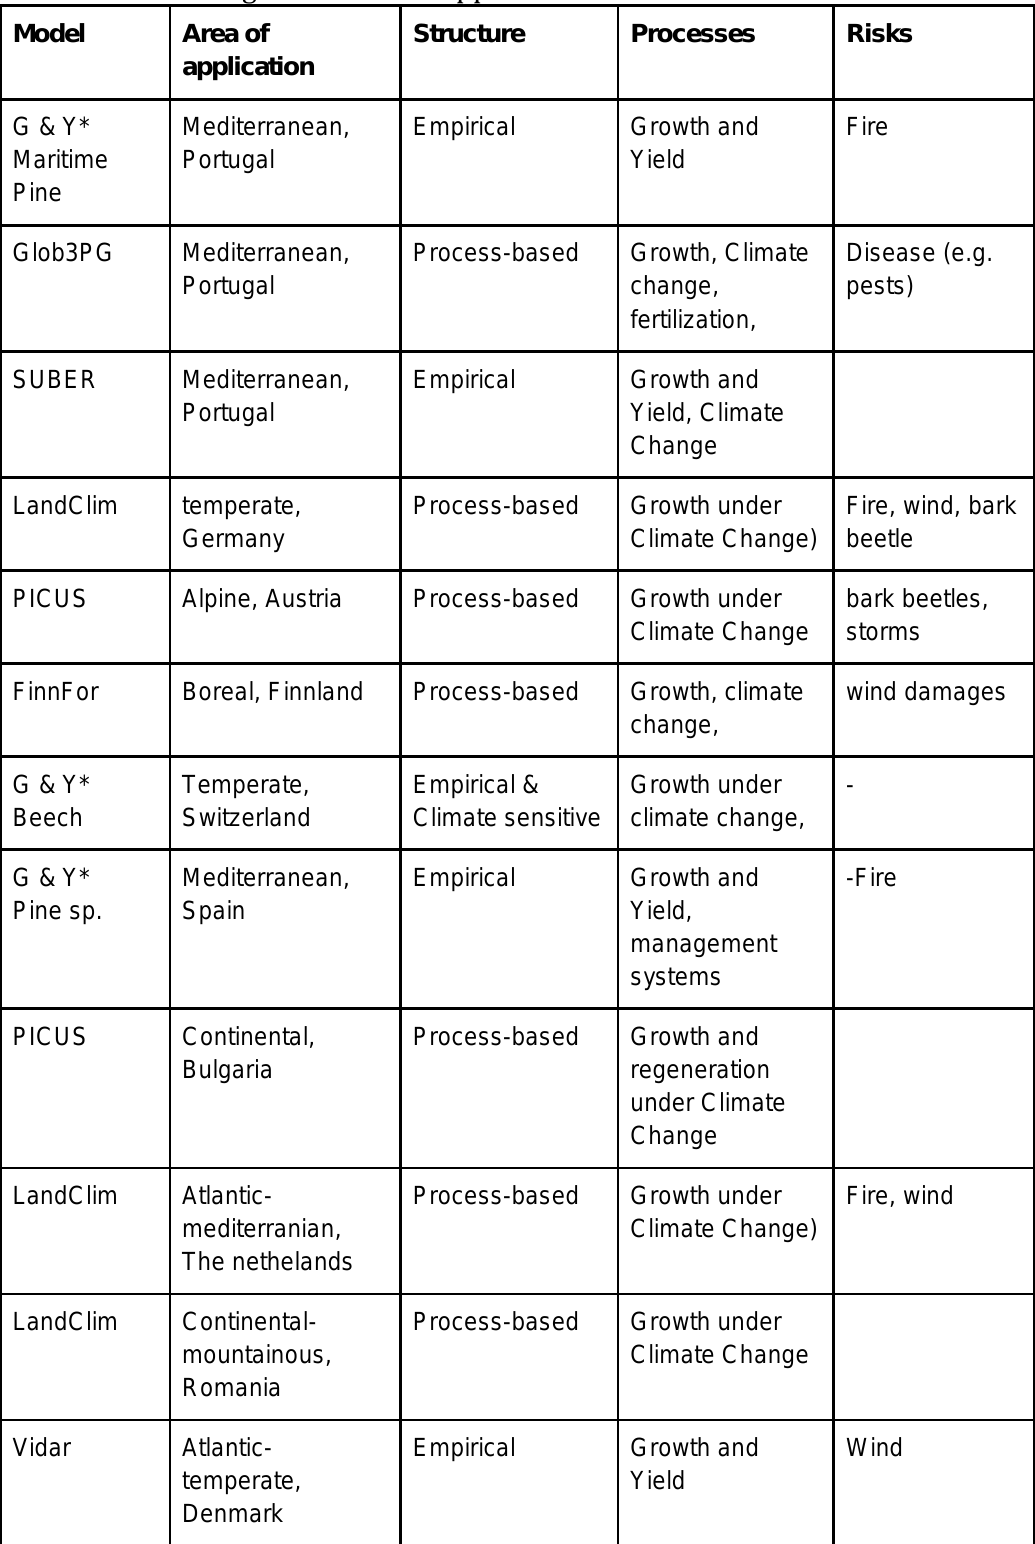
Table A2.1 Forest growth models applied in case studies and associates